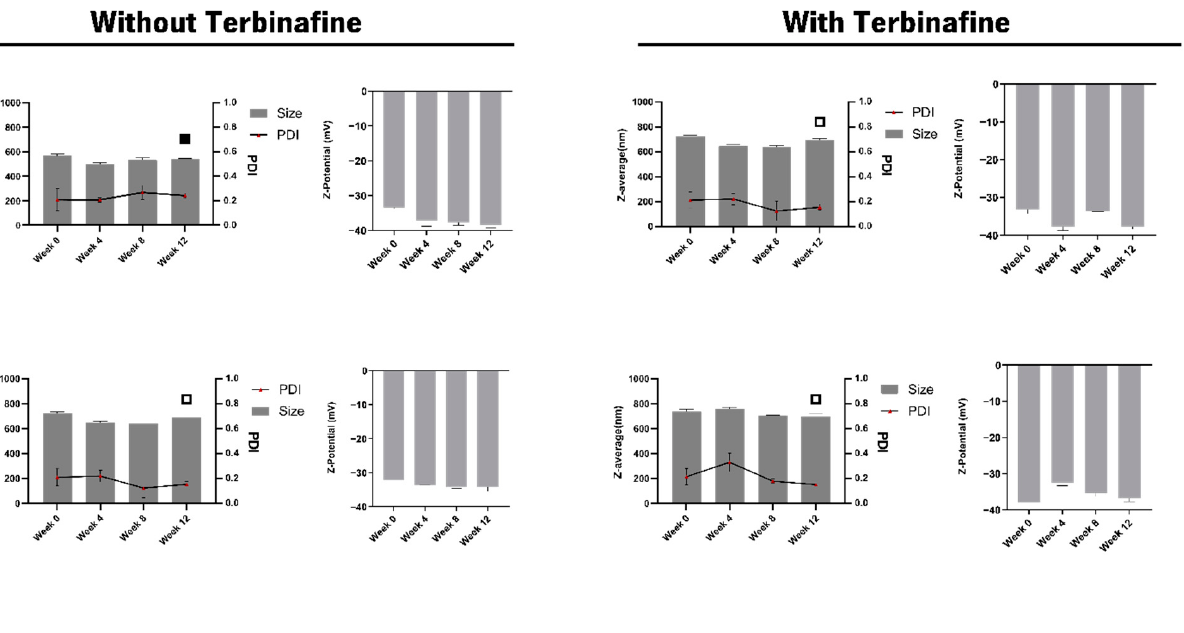
Figure 3. STEM micrographs (50,000×) of 100% keratin and 80% keratin/20% keratin-PEG particles.